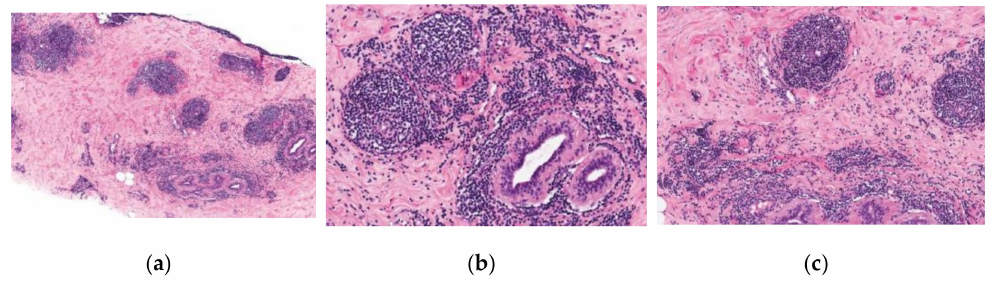
Figure 1. Microscopic examination of core-needle breast biopsy sample: ( a – c ) dense periductal, perilobular and perivascular chronic inflammatory reaction. Hematoxylin and eosin staining. Photos from Rosen’s Breast Pathology, 5th